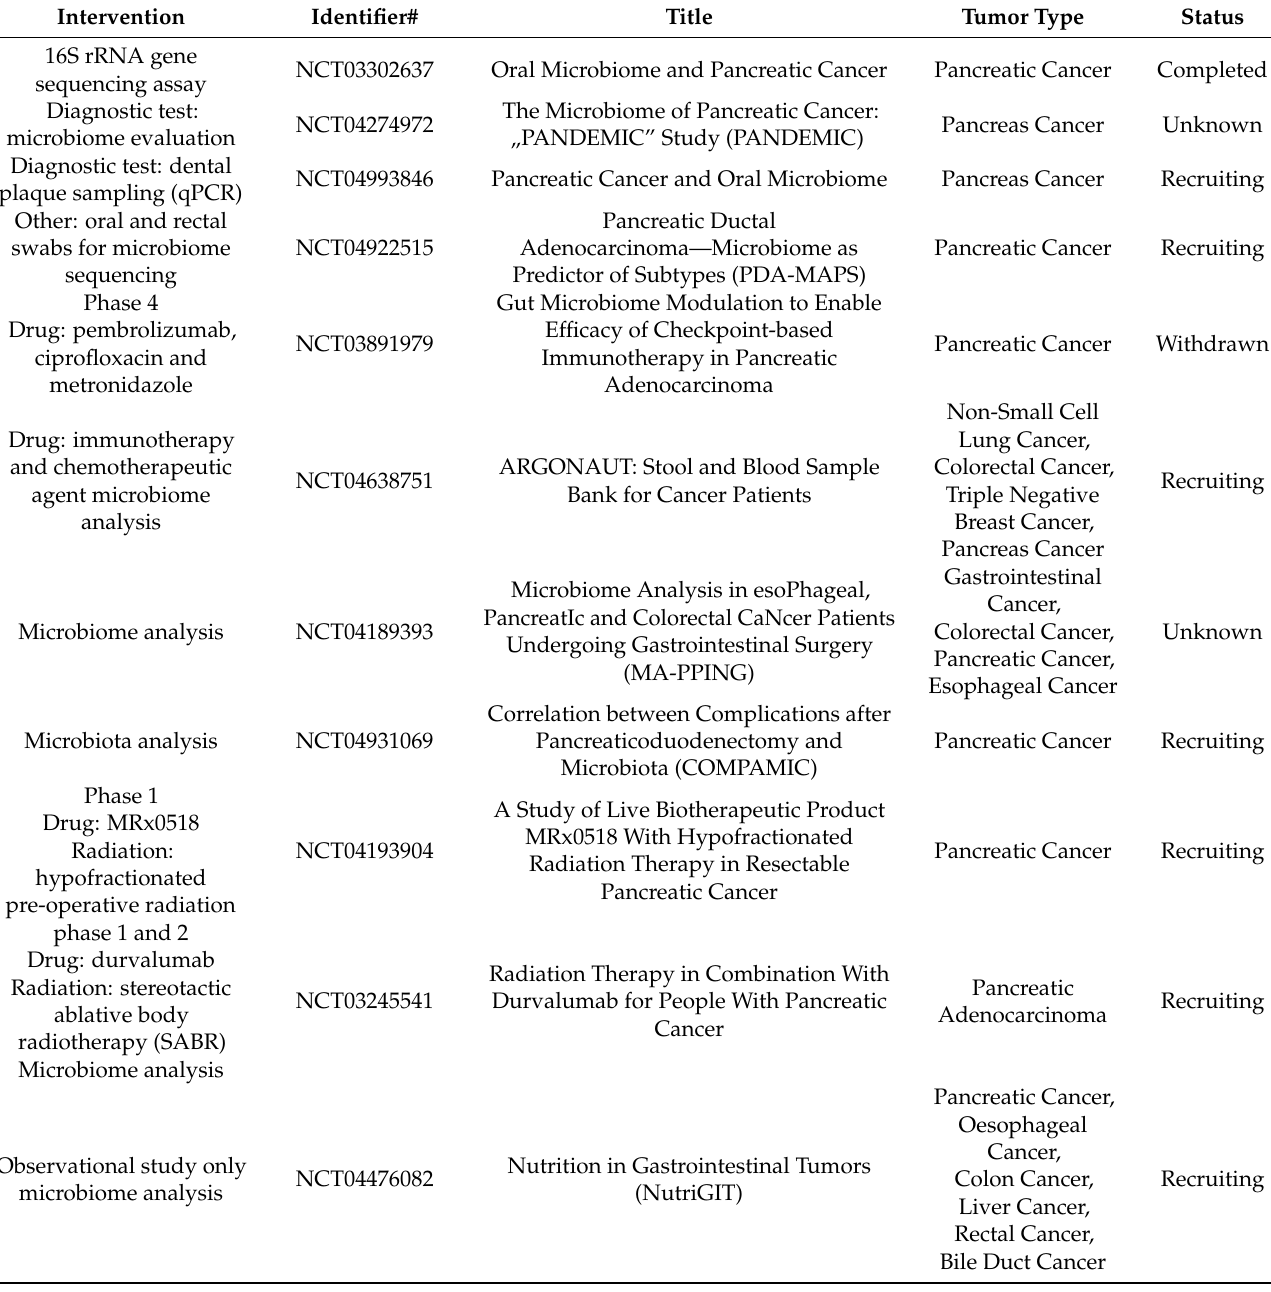
Table 2. Clinical trials to study the microbiota associated with pancreatic